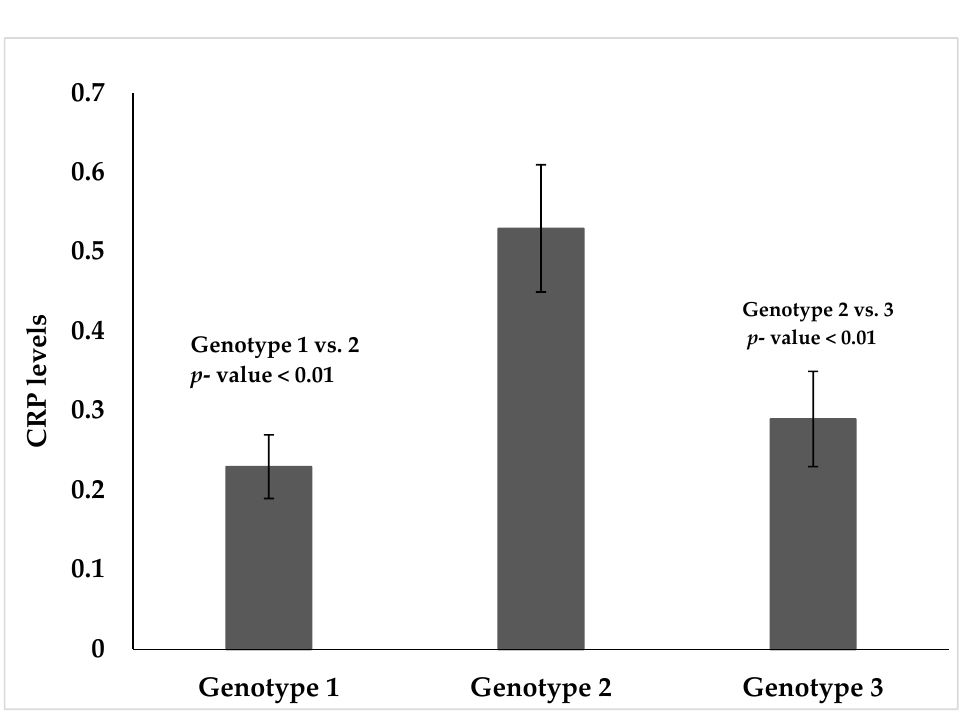
Figure 1. CRP levels by HCV genotypes adjusted for race, sex, and age.